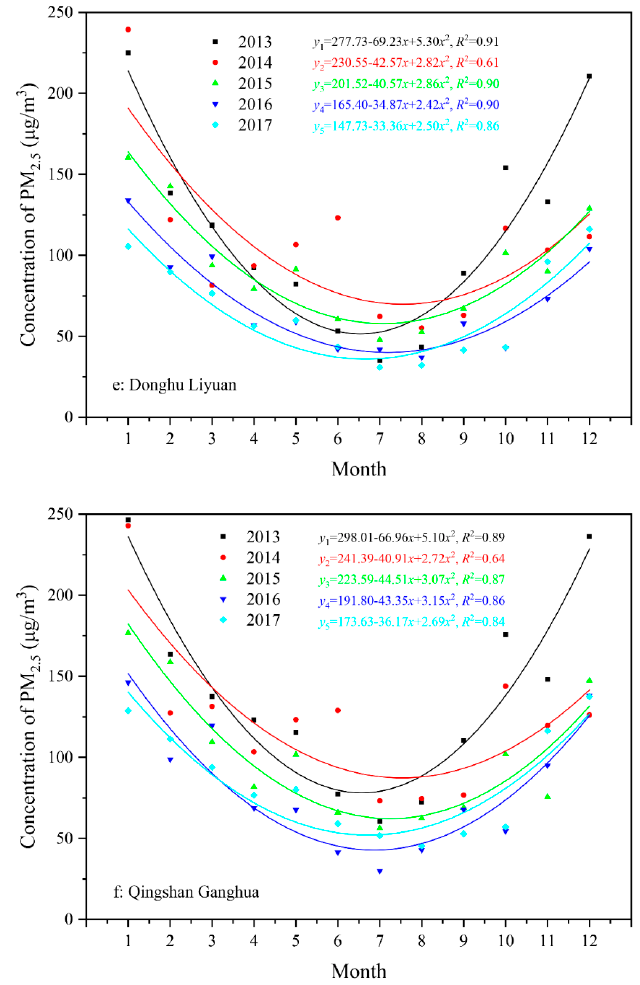
Figure 4. Variation trends of monthly mean PM 2.5 concentration at various monitoring sites during the period of 2013–2017.